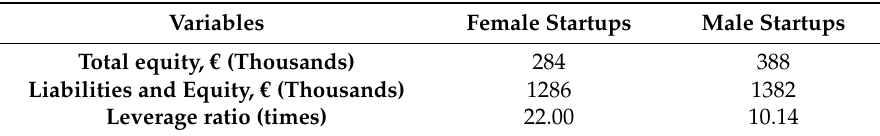
Table 8. Financial